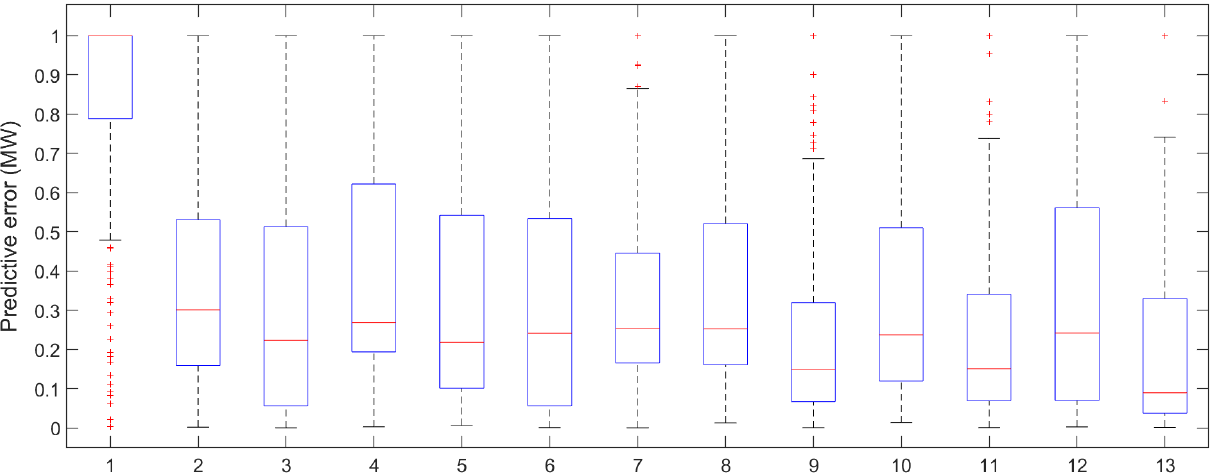
Figure 8. The box-plot of forecasting errors of the different models (1, Multi-Regress; 2, LSTM; 3, EMD-LSTM; 4, PSO-RBF; 5, EMD-PSO-RBF; 6, PSO-SVM; 7, EMD-PSO-SVM; 8, PSO-LSTM; 9, EMD-PSO-LSTM; 10, BES-LSTM; 11, EMD-BES-LSTM; 12, MBES-LSTM; 13, EMD-MBES-LSTM).